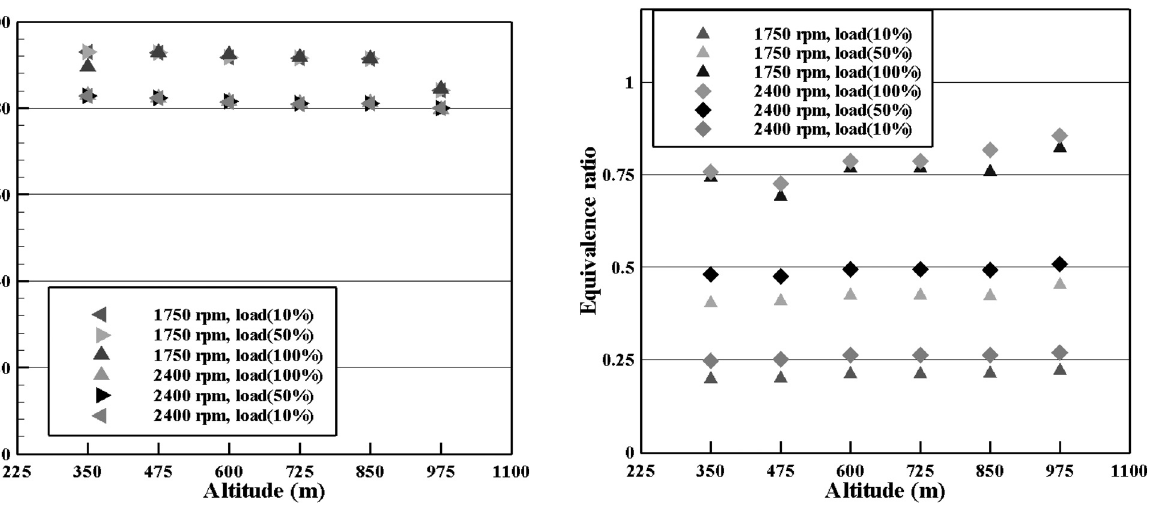
Fig. 3. Effect of altitude on volumetric efficiency Fig. 4. Effect of altitude on equivalence ratio